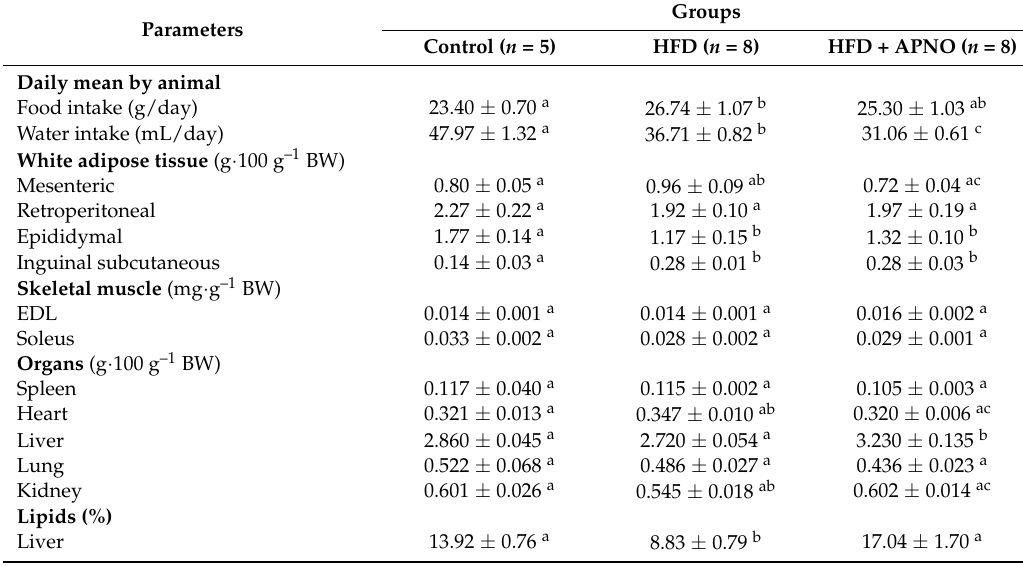
Table 2. The daily mean by animal of food (g) and water (mL) ingestion, and the relative mass of white adipose tissue depots, skeletal muscle, and organs of normolipidemic rats (Control) and high-fructose diet-induced hyperlipidemic rats treated with water (HFD) and A. phalerata nut oil (1.2 mL · Kg − 1 of body weight, HFD + APNO) for 63